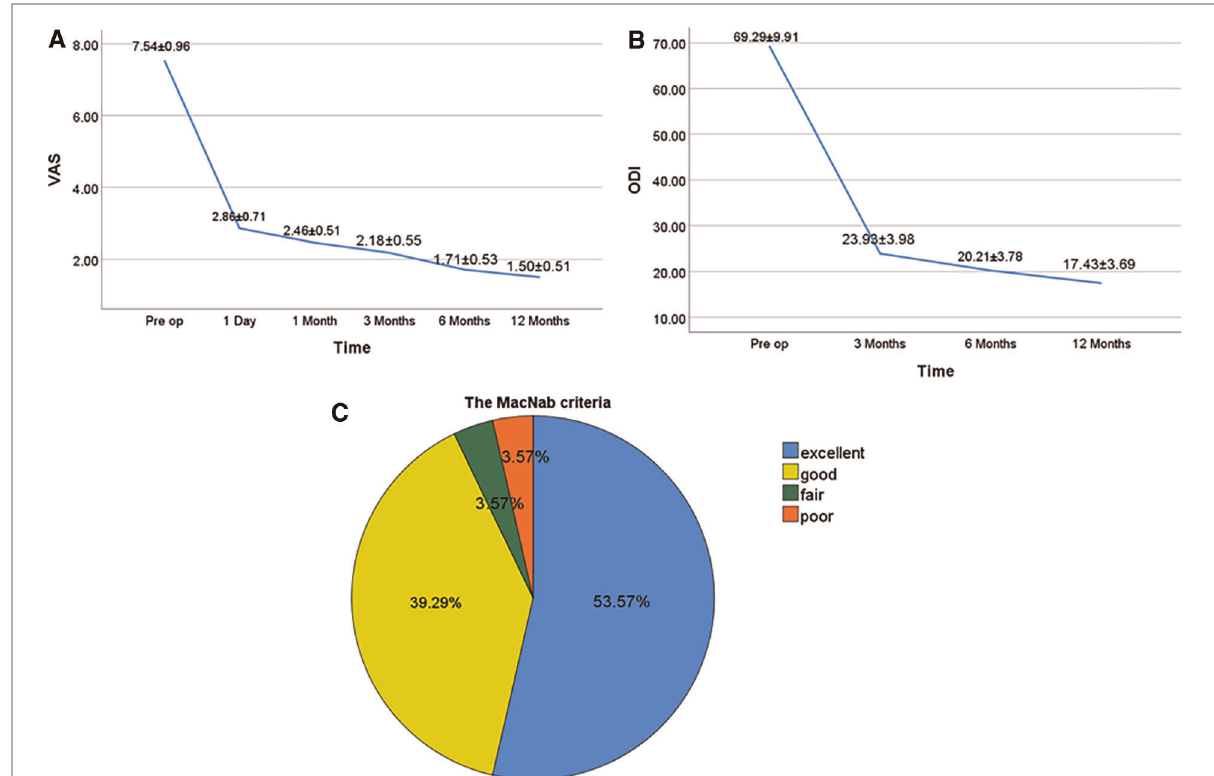
FIGURE 4 Clinical outcomes at different follow-up time points for pre- and postoperative PEID ( A – C ). ( A ) VAS scores for pre- and postoperative PEID. ( B ) ODI scores for pre- and postoperative PEID. ( C ) The modi fi ed MacNab criteria of all patients. P <0.05. VAS, visual analog scale; ODI, Oswestry disability index; Pre op,